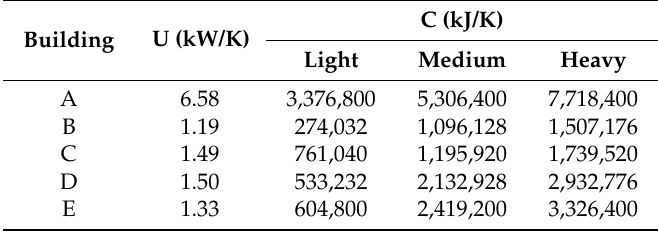
Table 4. U and C values calculated from tabular values for